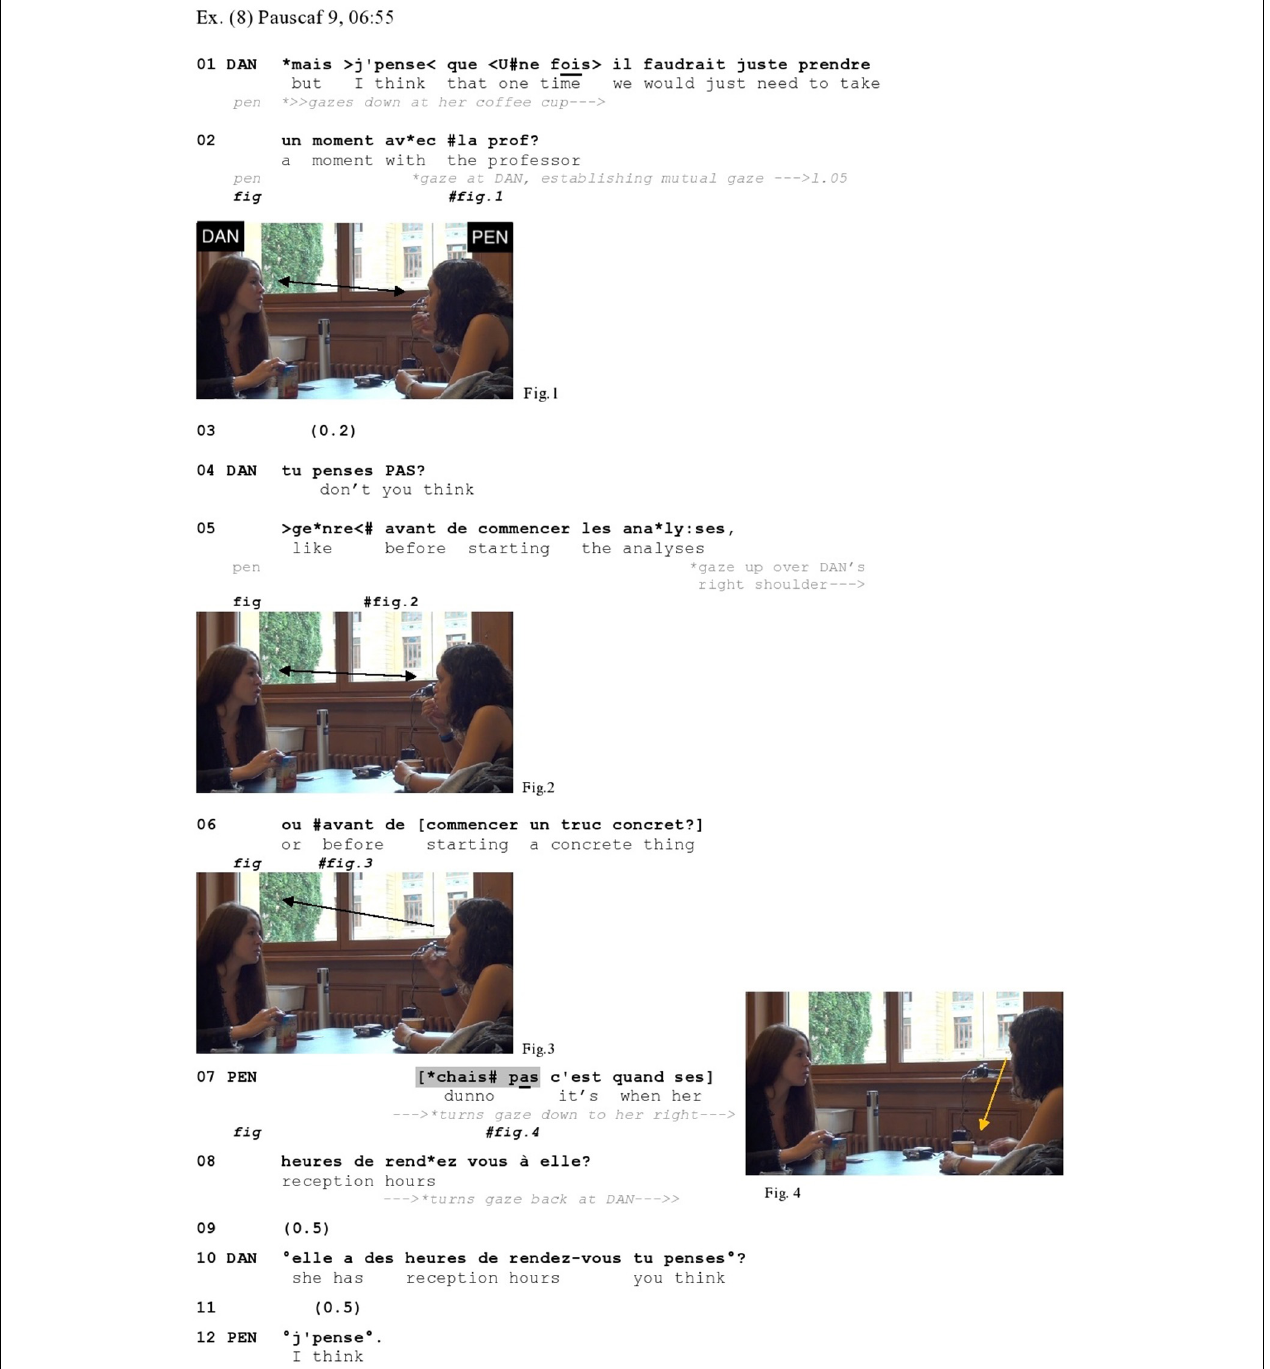
(Figure 3). In other words, gaze aversion is here deployed in a dispreferred response through